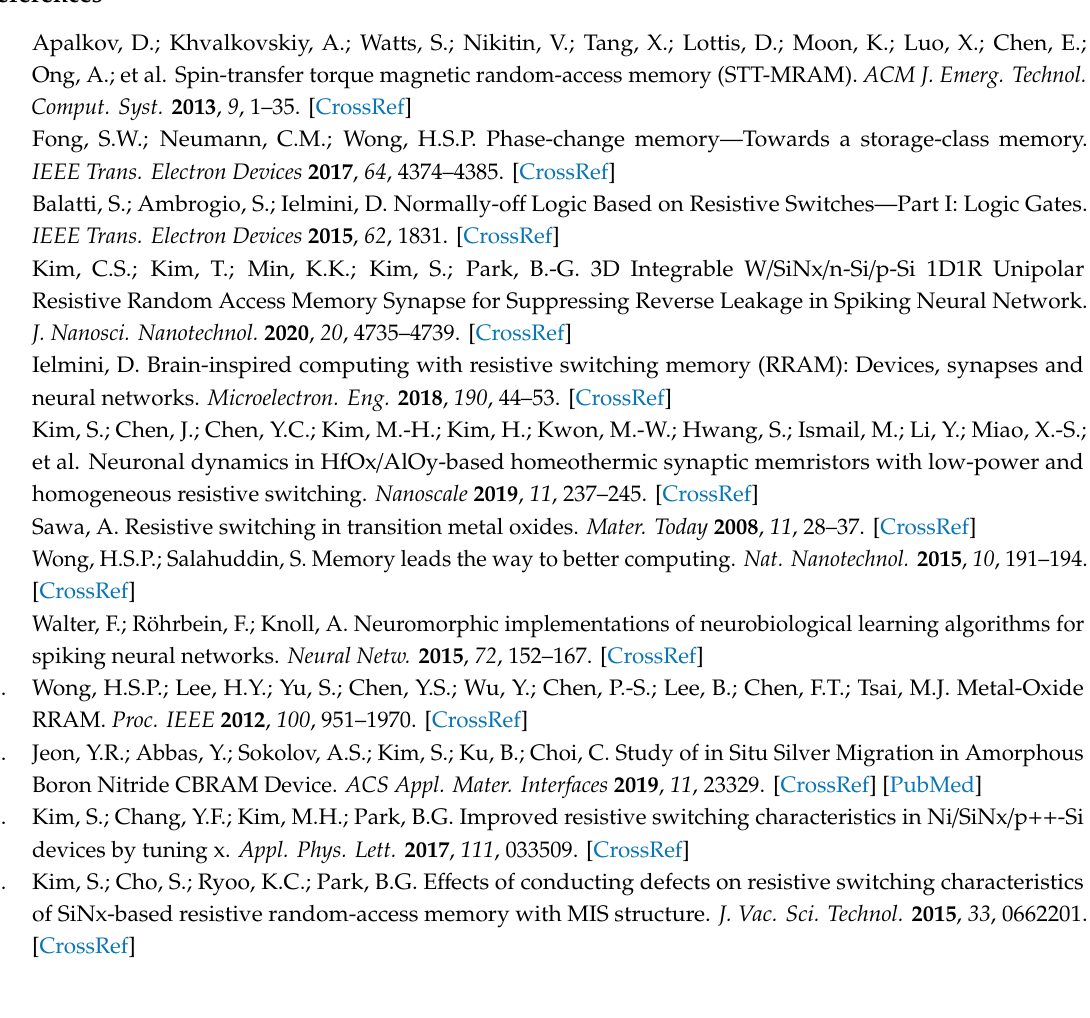
Figure S1: TEM image of single layer devices. Figure S2: I–V curves of Ni / BN / Si device. Figure S3: Classification of I–V curves in Ni / SiN / BN / n + -Si and Ni / SiN / BN / n ++ -Si